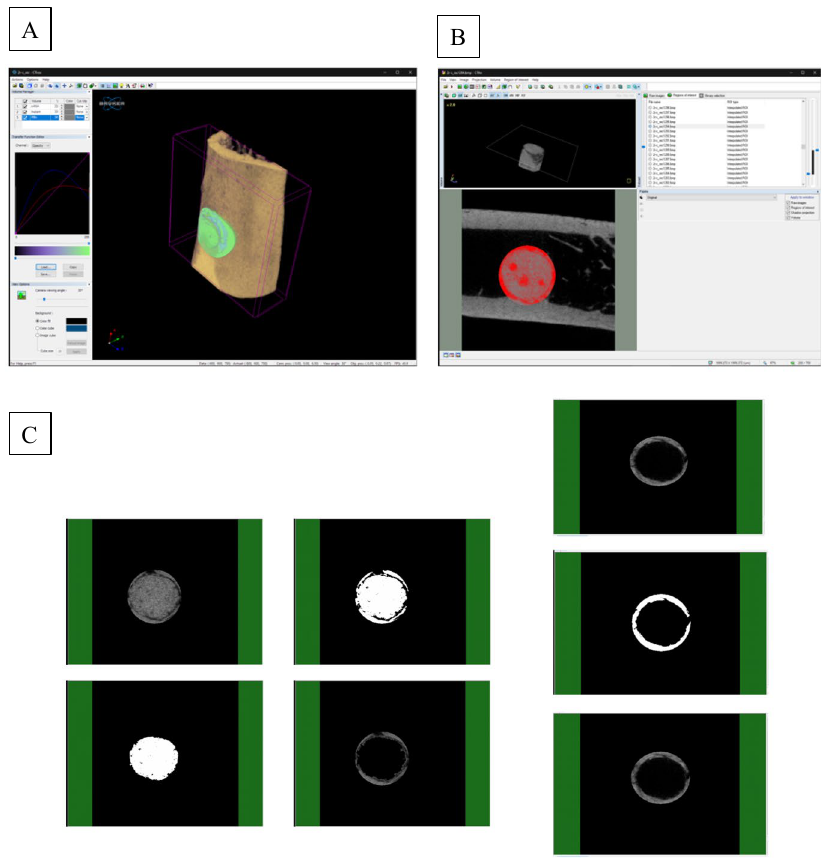
Figure 3. ( A ) represents 3D visualisation of the data on CTVox software, ( B ) is an overview of CTAn software where the Raw Tomographic image sequence is reconstructed based on a multi-dimensional projection into a grayscale image sequence. The bottom left images show the suitable threshold range for segmenting the implant from bone tissue. ( C ) illustrates the region of interest (ROI) loading into the Batch manager (BatMan) for volumetric analysis of the regenerated bone and subsequent sub-data generation for 3D rendering. Data sets are binarised using the range of 50–255 (representing bone) and volumetric analysis was conducted to quantify the amount of bone within the specified region. A subset is generated for rendering the regenerated bone (RBn) and the void space (VOID,